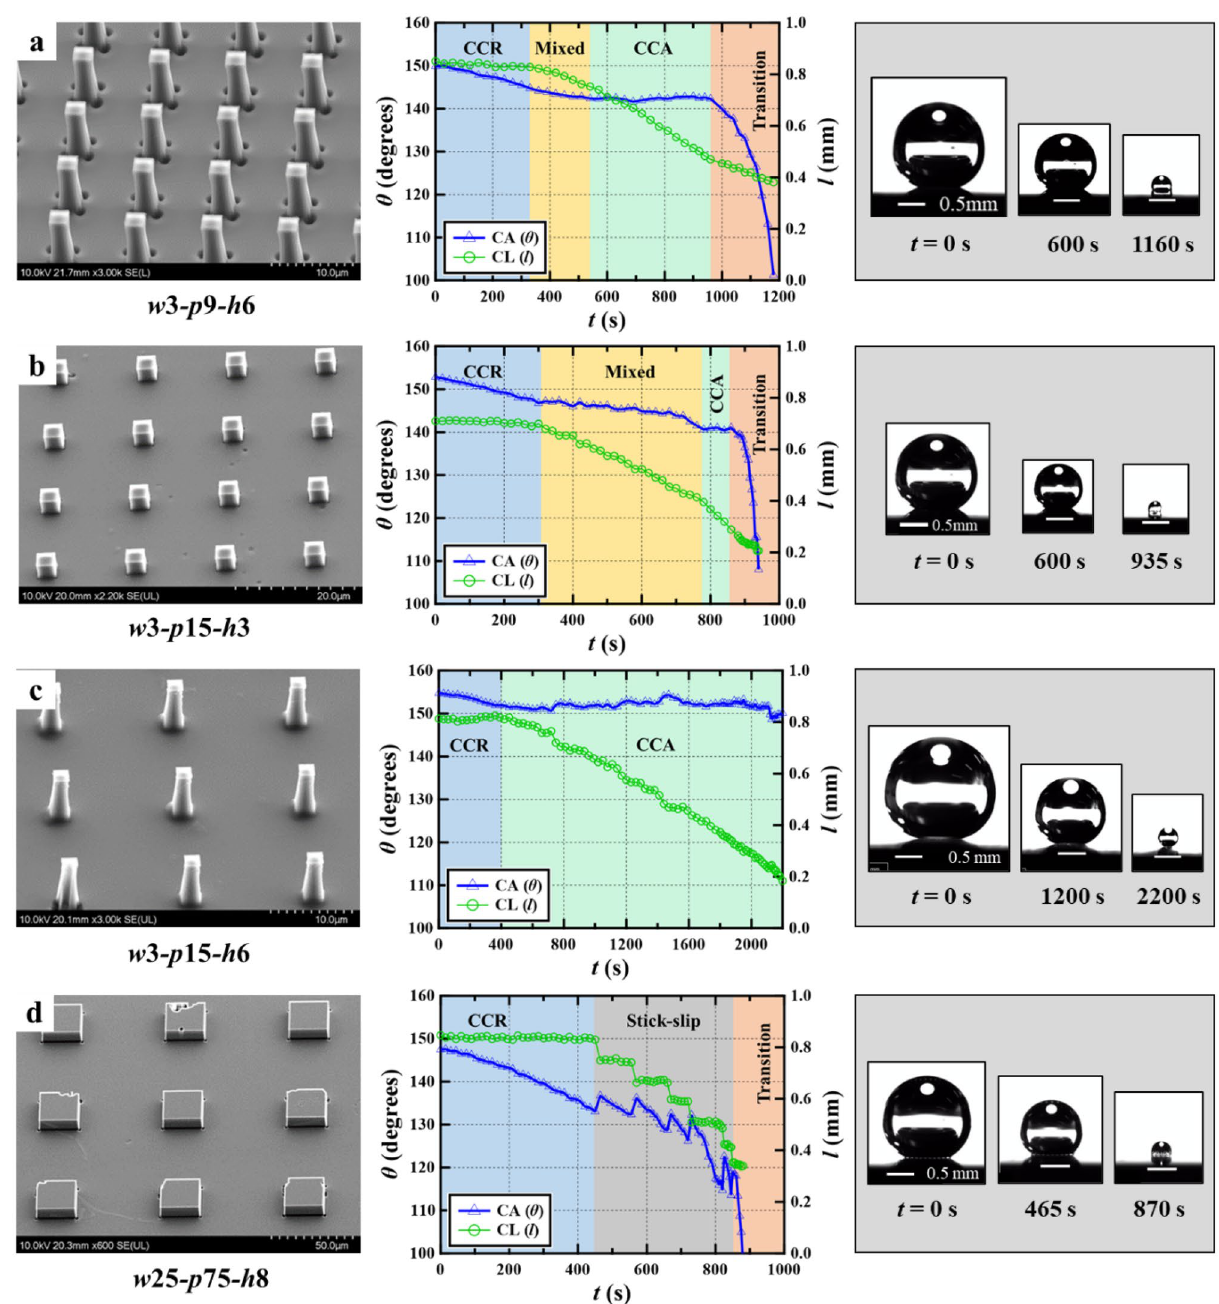
Figure 6. Dynamics of evaporation on the other four different DLC-based